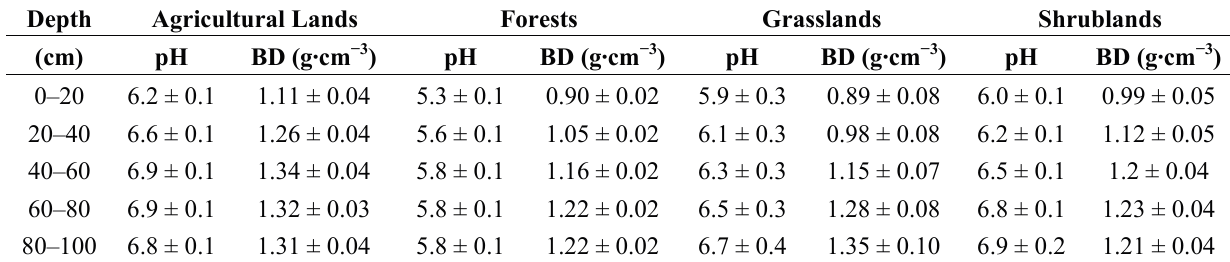
Table 2. Soil pH and bulk density (BD) (means ± standard error mean) at different depths under different LULC